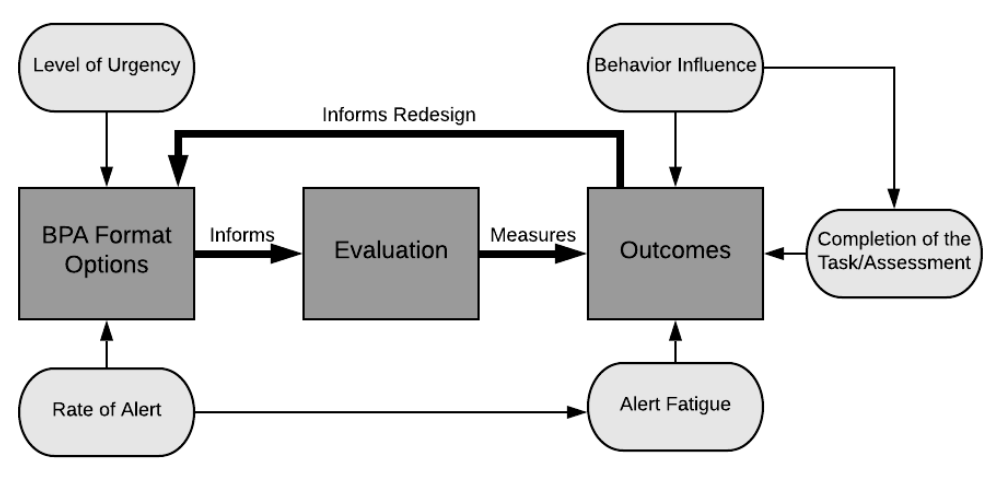
Figure 1. Alert Format Evaluation Model.